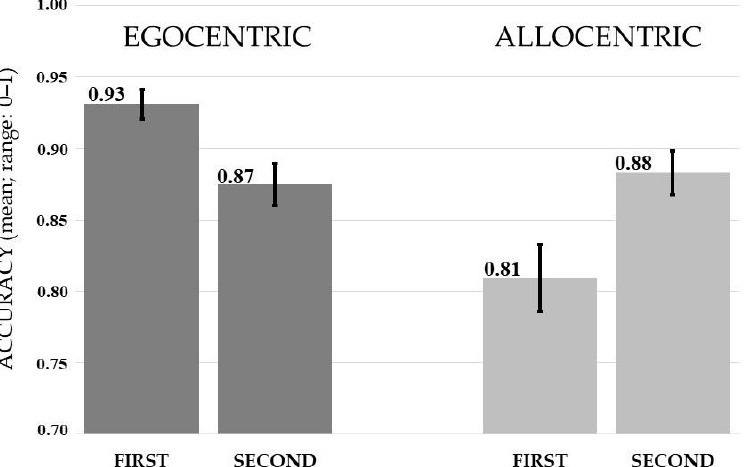
Figure 3. The graph shows the mean accuracy of egocentric and allocentric judgments as a function of the order of presentation of the stimuli (i.e., first vs. second). Vertical bars represent standard errors.